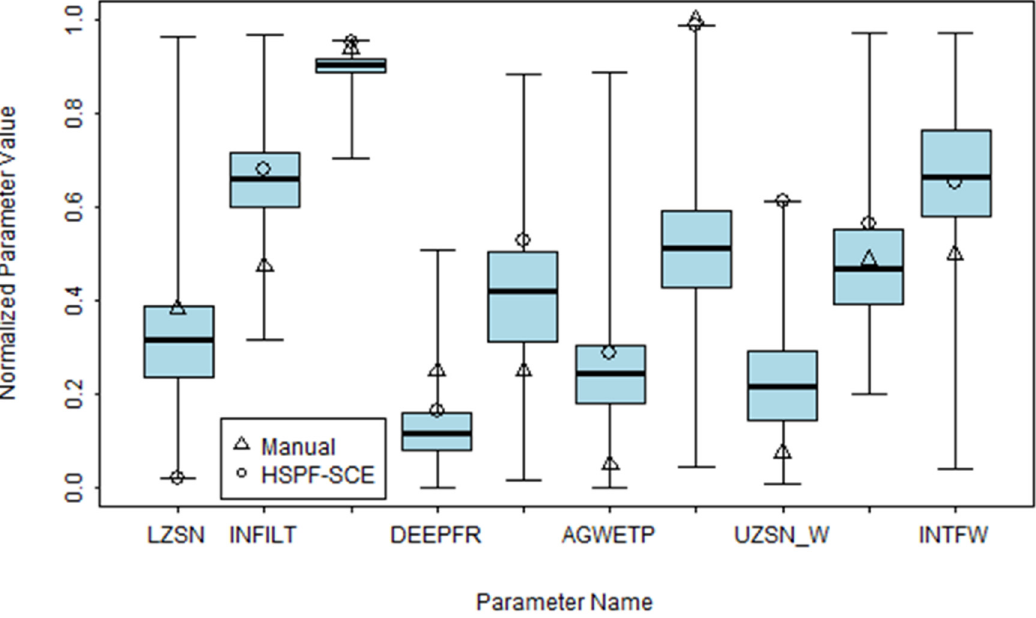
Figure 6. Comparison of parameter values calibrated by the HSPF-SCE and manually calibrated parameter values for the Reed Creek watershed (UZSN_W is for winter season and UZSN_N is for non-winter